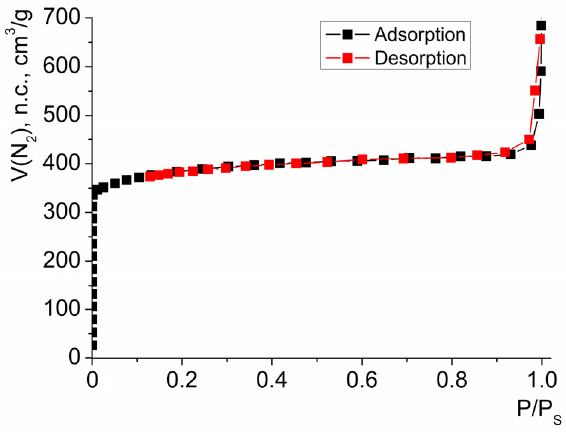
Figure 3. An isotherm of nitrogen sorption by HKUST-1 used in this study.